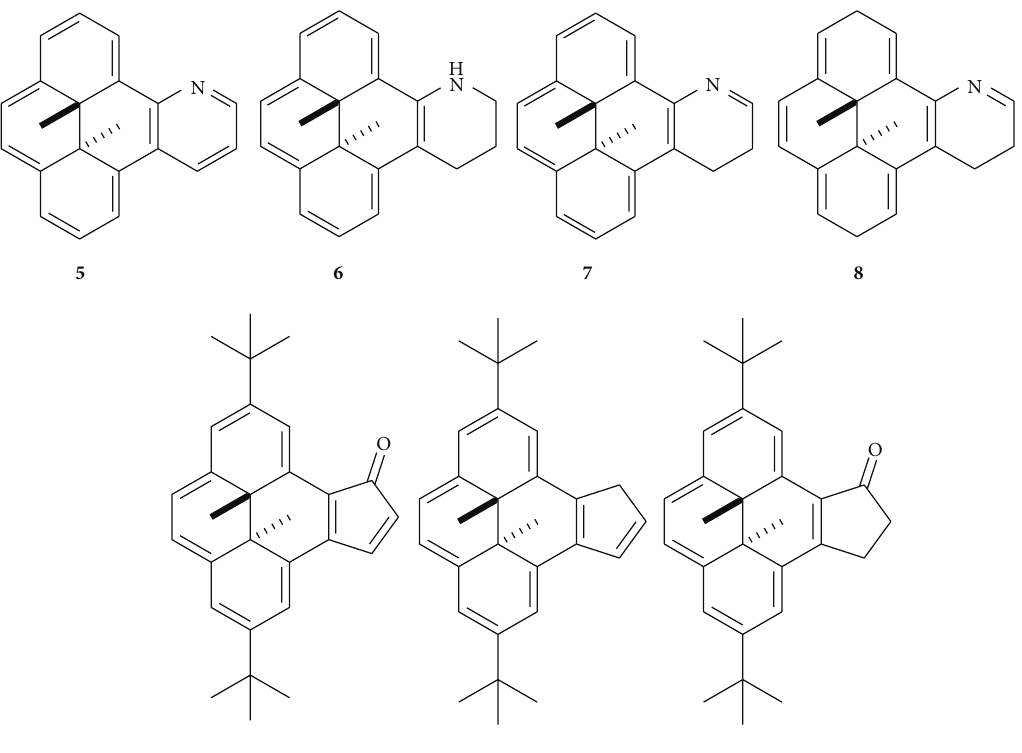
Figure 2: Pyridine and cyclopentadienone fused dihydropyrenes and their nonaromatic and nonconjugated reference models, required for quantification of aromaticity through (2) and (5).